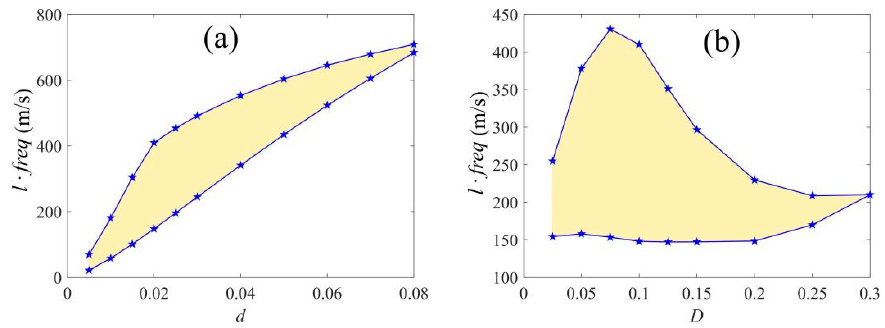
Figure 5. The effects of the dimensions ( a ) d ( b ) D on the pentamode bands.